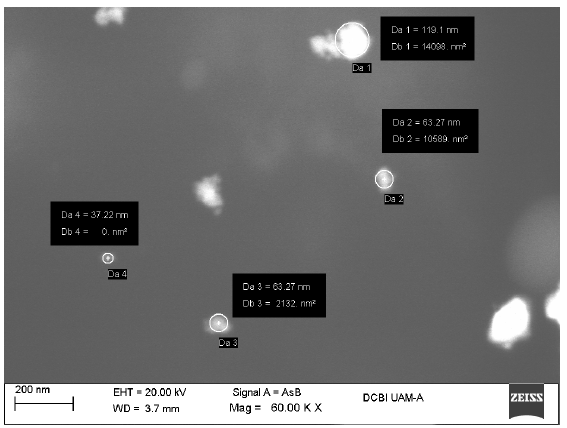
Figure 2. SEM micrographs of zirconia nanoparticles synthesized employing the sol-gel technique.